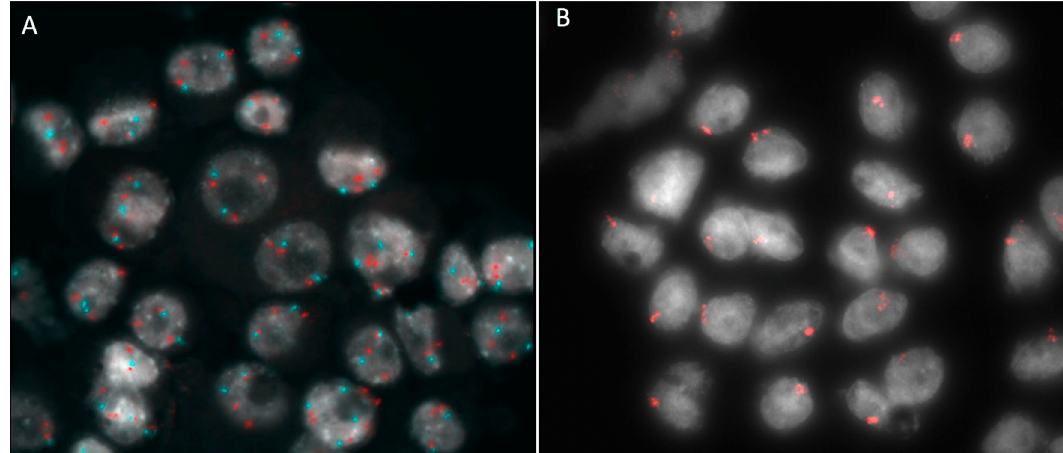
Figure 7. Fluorescence in situ hybridization analysis (FISH) in a case of posterior uveal melanoma sampled by fine needle aspiration biopsy. ( A ) FISH with locus specific probe for MYC gene (red) and for the centromere of chromosome 8 (light blue) confirmed the gain of 8q24 showing three copies of MYC gene in each cell; ( B ) The same case was also characterized by monosomy 3: cells with a single red hybridization signal have lost one chromosome 3.